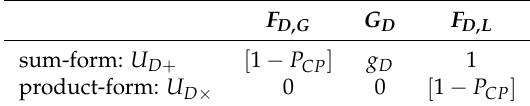
Table 2. Gain and cost terms for sum-form and product-form utilities of the